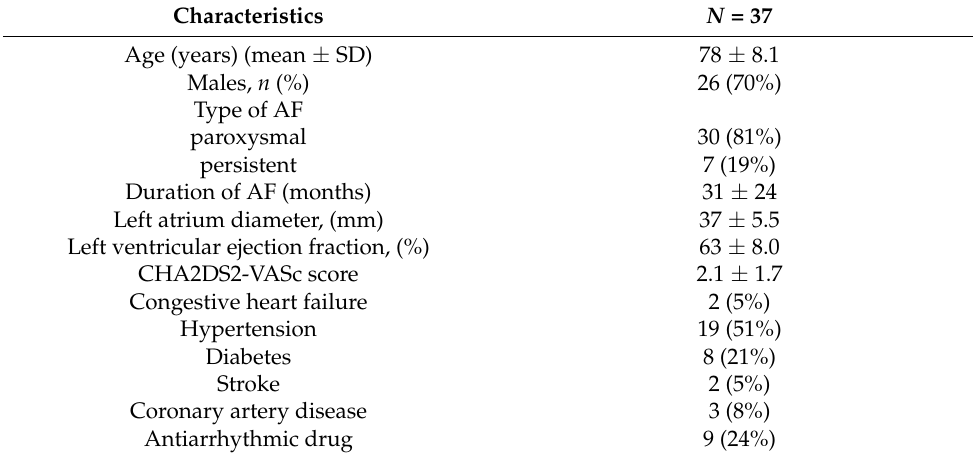
Table 1. Patient Characteristics.